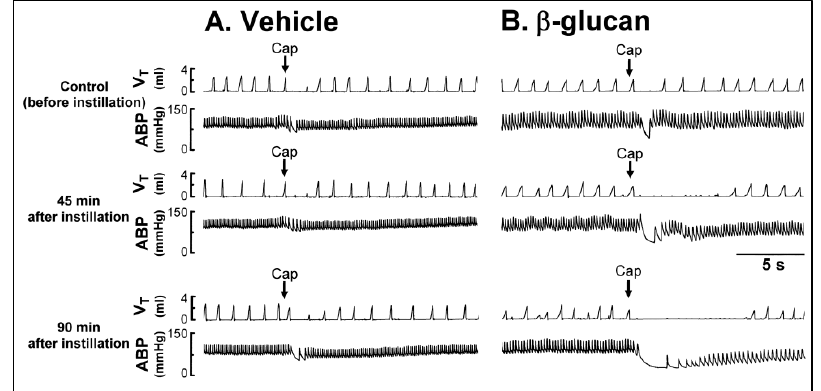
Figure 1. Experimental records illustrating the pulmonary chemoreflex responses to right-atrial injection of capsaicin (Cap, 1 μg/kg; arrows) before, 45 min after, and 90 min after intratracheal instillation of ( A ) vehicle (isotonic saline) or ( B ) β-glucan (5 mg/0.1 mL/rat) in two anesthetized, spontaneously breathing rats (vehicle: 305 g; β-glucan: 310 g). V T , tidal volume; ABP, arterial blood pressure. Please note that the pulmonary chemoreflex responses evoked by capsaicin were enhanced by the β-glucan instillation, but not altered by the vehicle instillation.